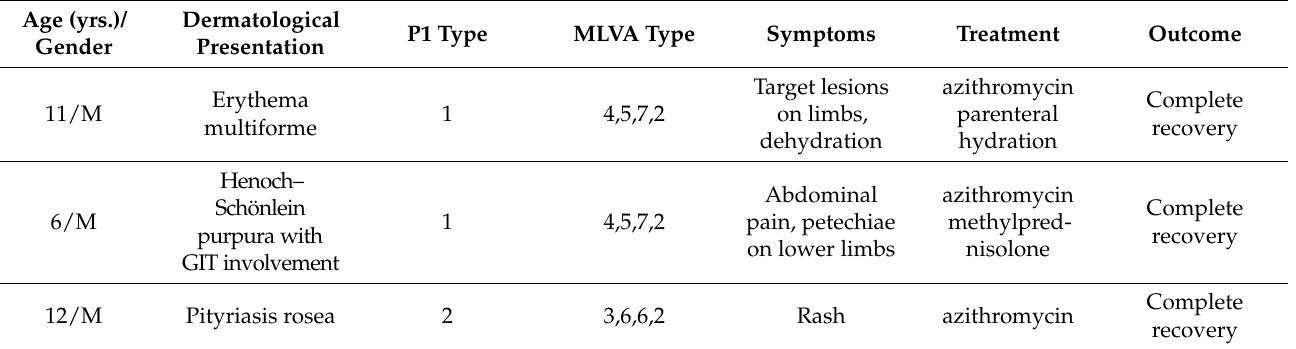
Table 4. Characteristics of patients with rare dermatological presentations of Mycoplasma-pneumoniae - induced cutaneous